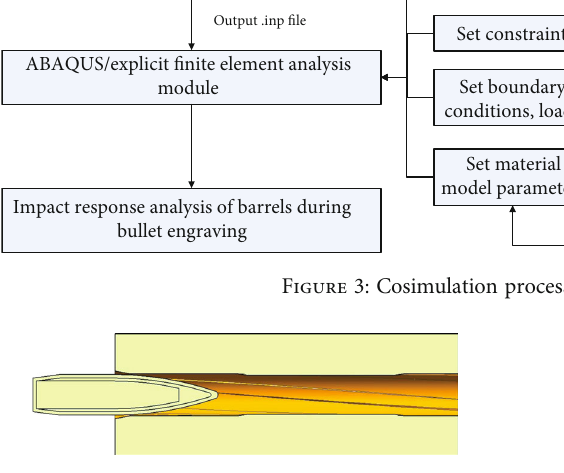
Figure 4: Three-dimensional models of barrels and